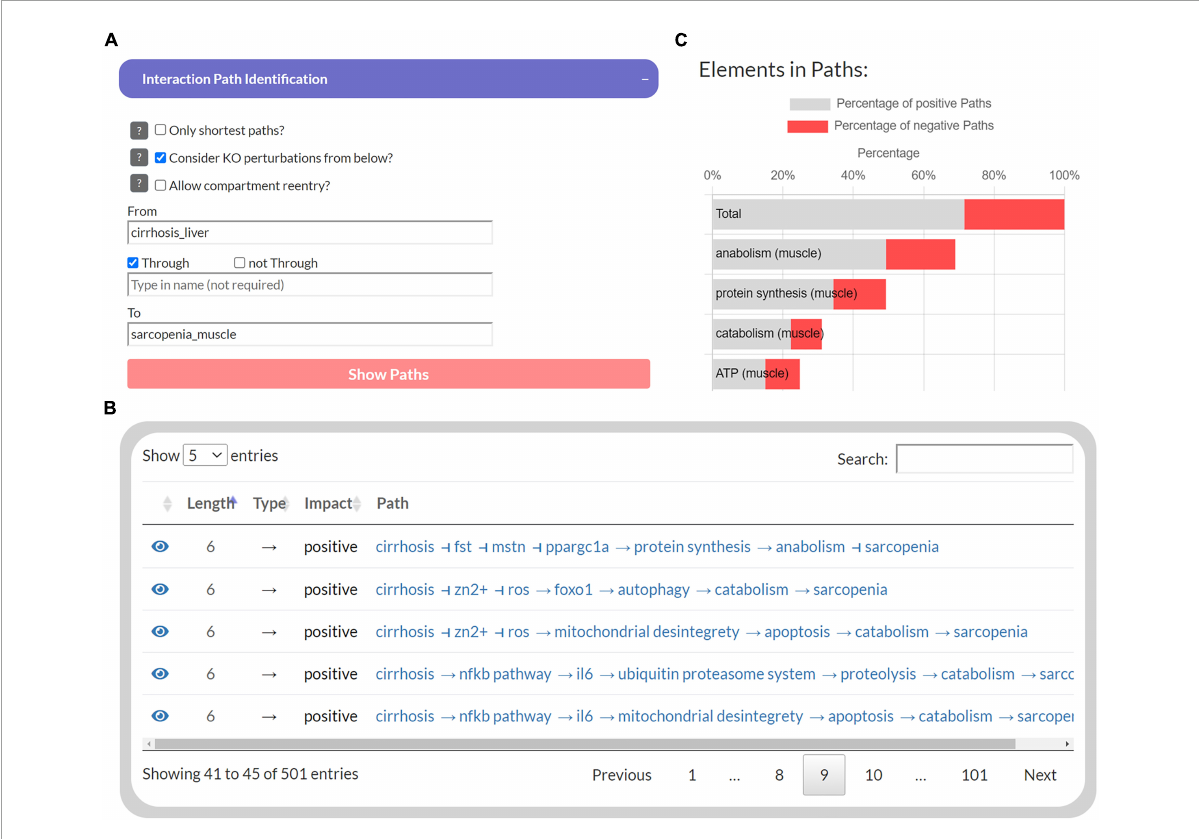
FIGURE3 The user interface to identify interaction paths between selected elements in the Sarcopenia Map. For selected elements (A) , their interaction pathways are listed in a table (B) Additionally, elements along the pathways are ranked by their percentages of appearance separated by the type of interaction (C)